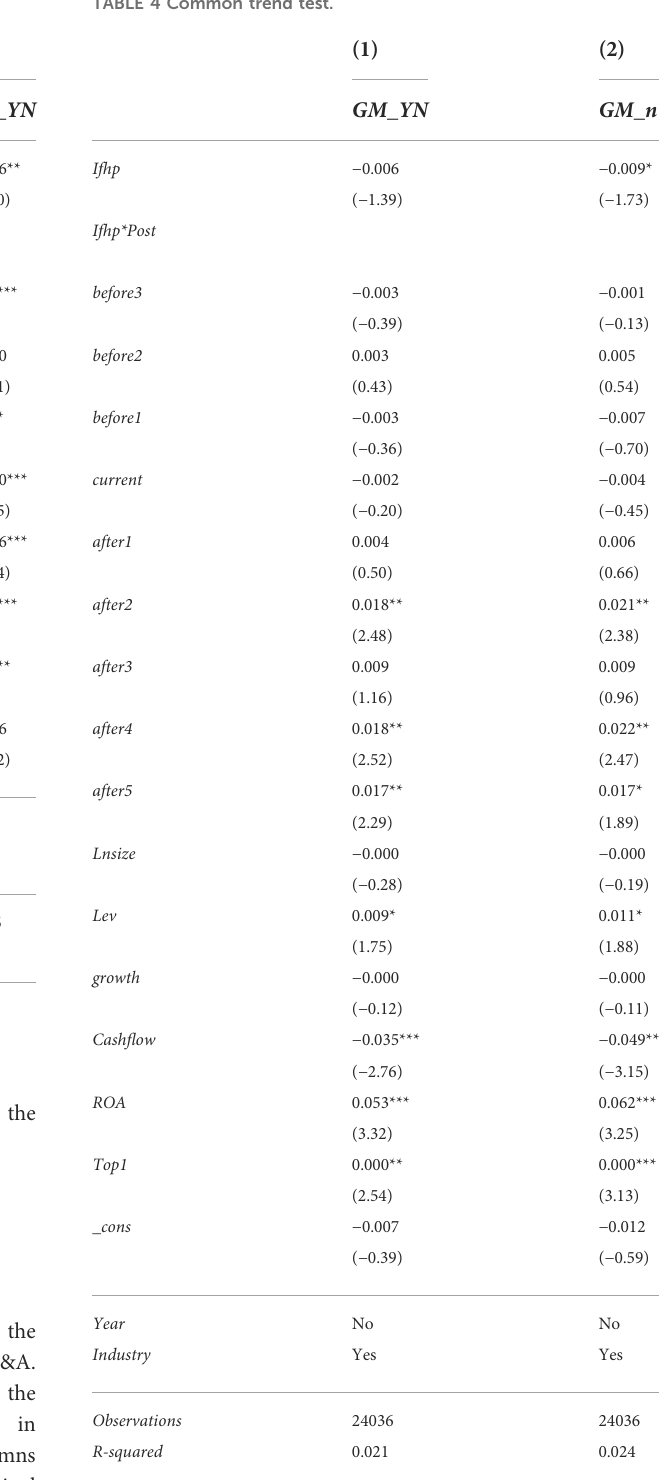
TABLE 3 The impact of the new EPL on corporate green M&A. TABLE 4 Common trend